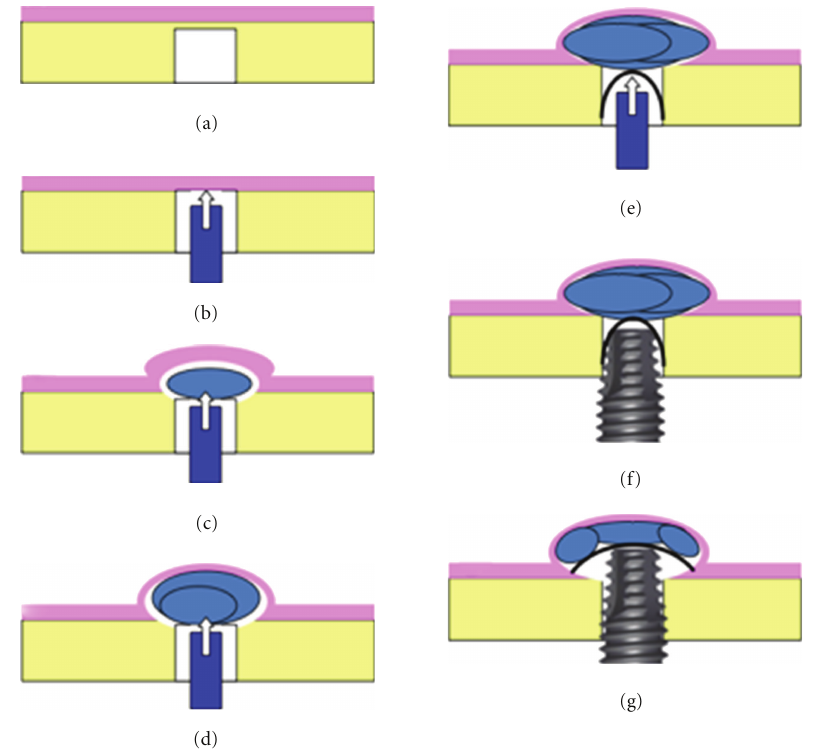
Figure 4: Schematic representation of osteotome-mediated sinus lift technique with the use of PRGF.